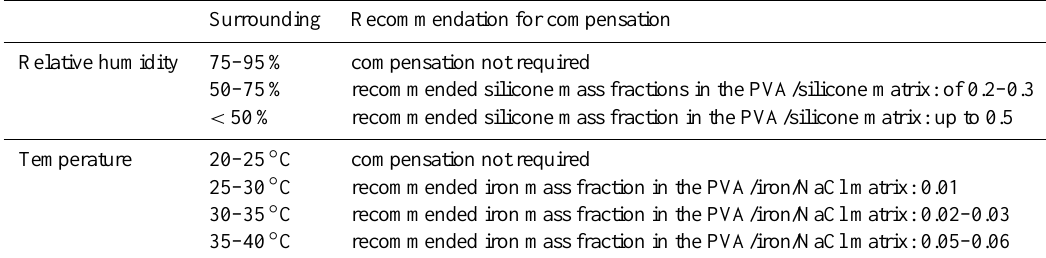
Table 5. Recommendations for temperature and humidity